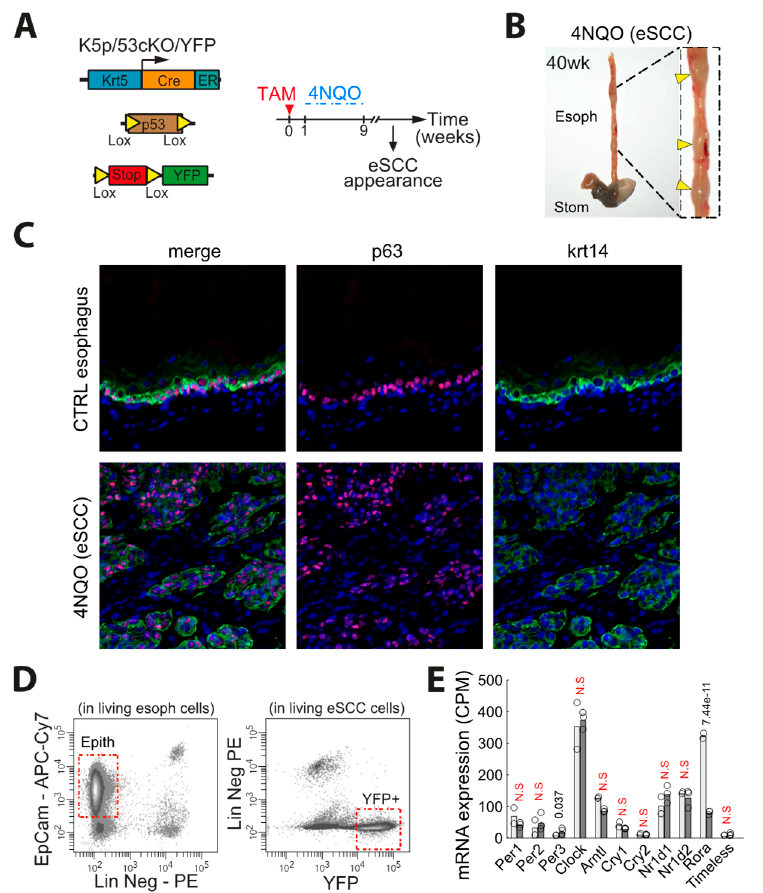
Figure 5. Per2 expression oscillates in primary culture of mouse eSCC cells and influences sensitivity to chemotherapy. ( A ) Genetic strategy and experimental design. ( B ) Representative picture of 4-NQO-induced eSCC in K5:p53:YFP mouse esophagus. ( C ) Co-immunostaining of p63 and Krt14 in normal esophagus and 4-NQO-induced eSCC. ( D ) FACS plot showing the expression of EpCam and lineage negative markers (CD45, CD31, and CD140a) in control esophageal cells, and YFP and lineage negative markers in 4-NQO-induced eSCC. ( E ) Expression of clock-related genes measured by RNA sequencing in FACS sorted Epcam+ normal esophagus epithelial cells ( n = 2) and YFP+ 4-NQO-induced eSCC epithelial cells ( n = 3). FDR is indicated for each gene. Benjamini–Hochberg method on the p -values was used to control the false discovery rate (FDR). FDR>5% are considered non-significant (N.S). “Epith” means epithelial cells.